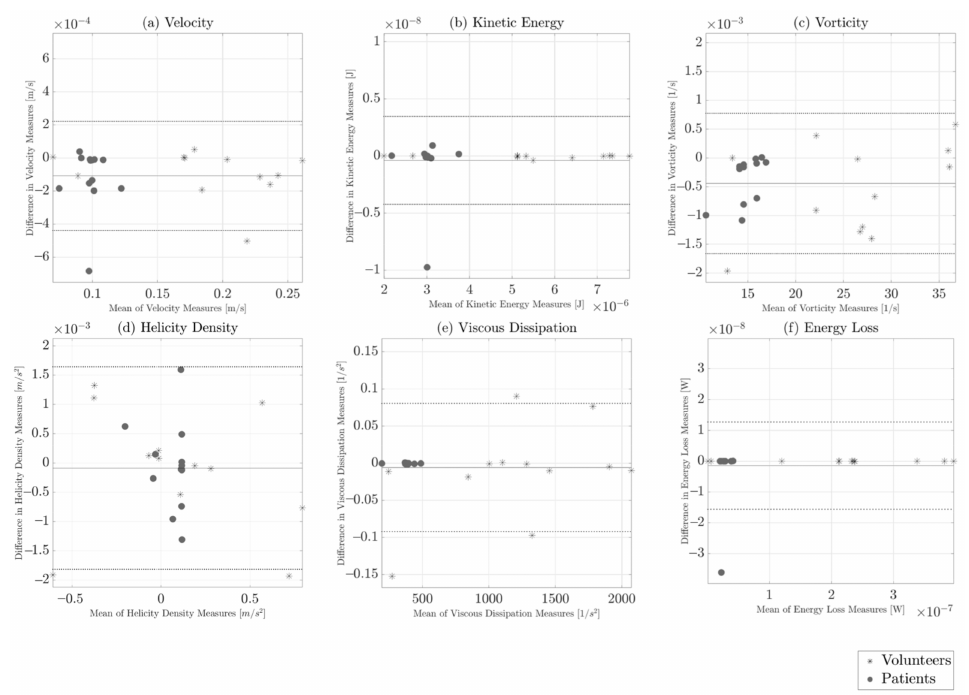
Figure A2. Bland-Altman plots represent the intra-observer reproducibility in the measurements of LV global hemodynamic parameters ( a – f ) at e-wave. The thick line represents the mean difference, and the thin lines represent the limits agreement (1.96 SD).